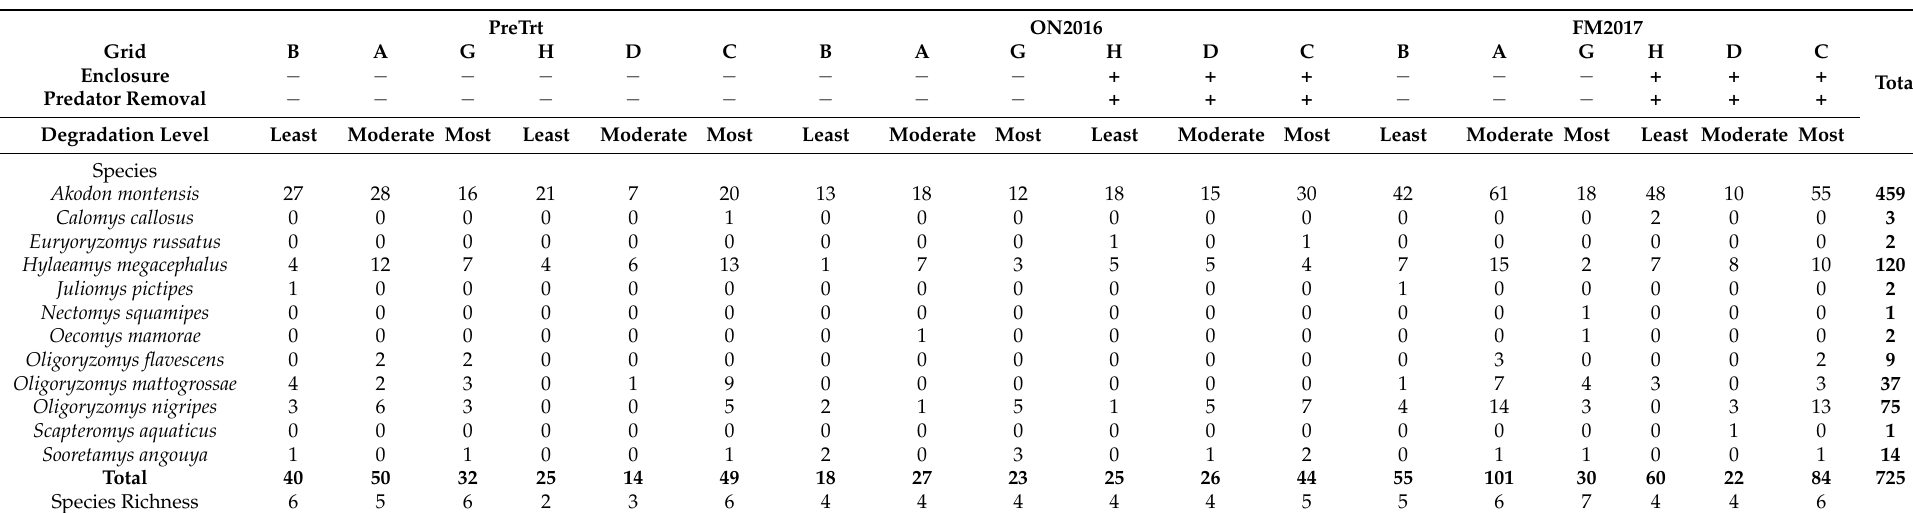
Table 1. Summary of the unique captures per grid and